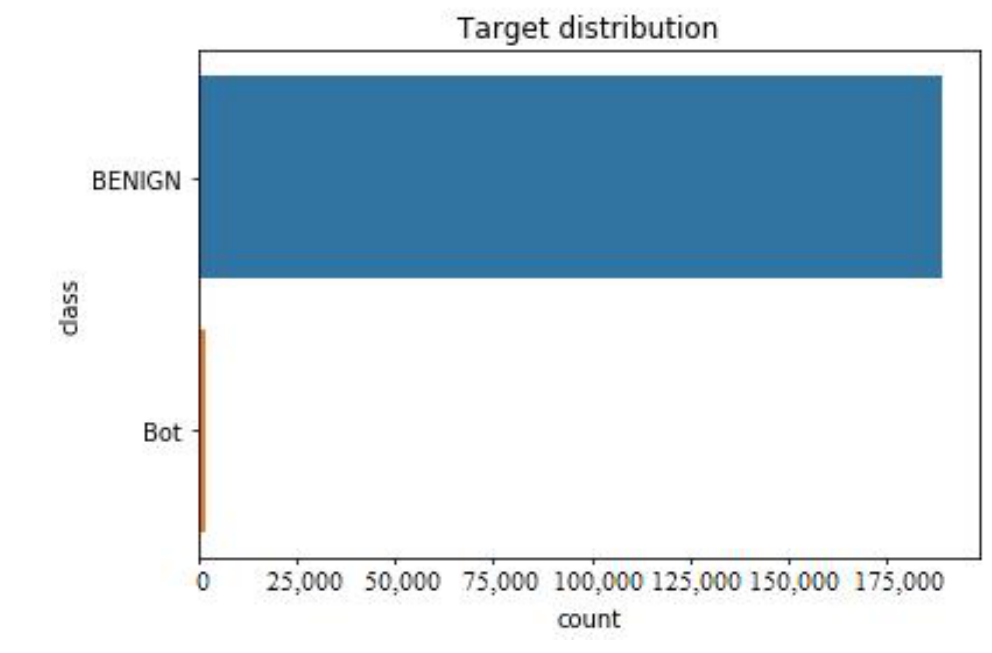
Figure 7. Target variable distribution in CICIDS2019. Table 3. CICIDS2019 dataset